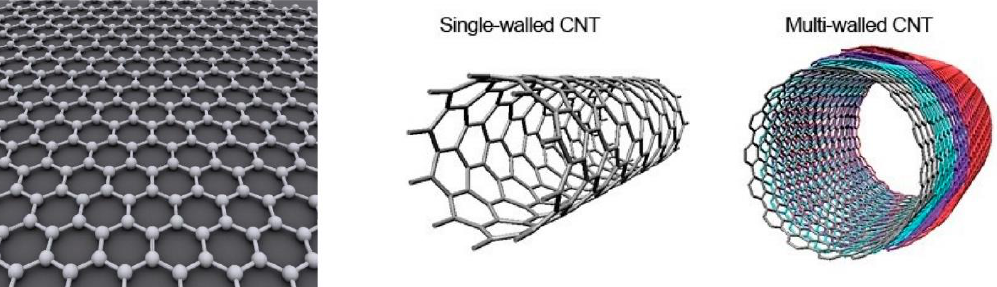
Figure 2. Basic structure of graphene ( left ), single-walled carbon nanotube ( middle ) and multi- walled carbon nanotube ( right , the layers between the MWNTS are distinguished by different colors). Reproduced from Gookbin et al. [44] by permission of Molecular Diversity Preservation Inter- national.